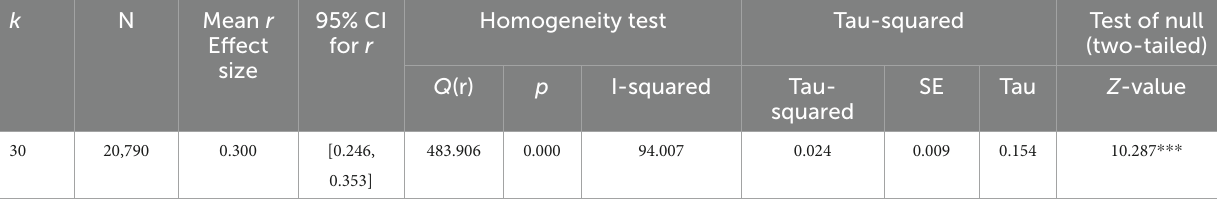
TABLE 2 Model of the correlation between IGD and AG.